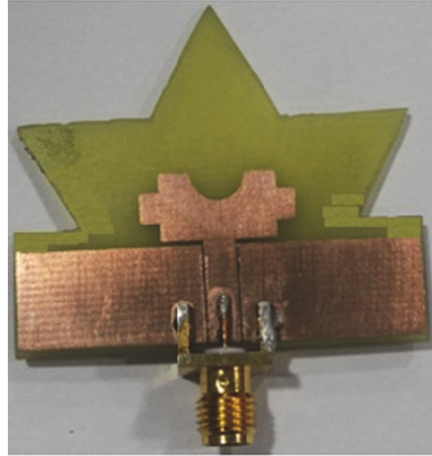
Figure 2: Photograph of the fabricated defected substrate CPW-fed wideband antenna.